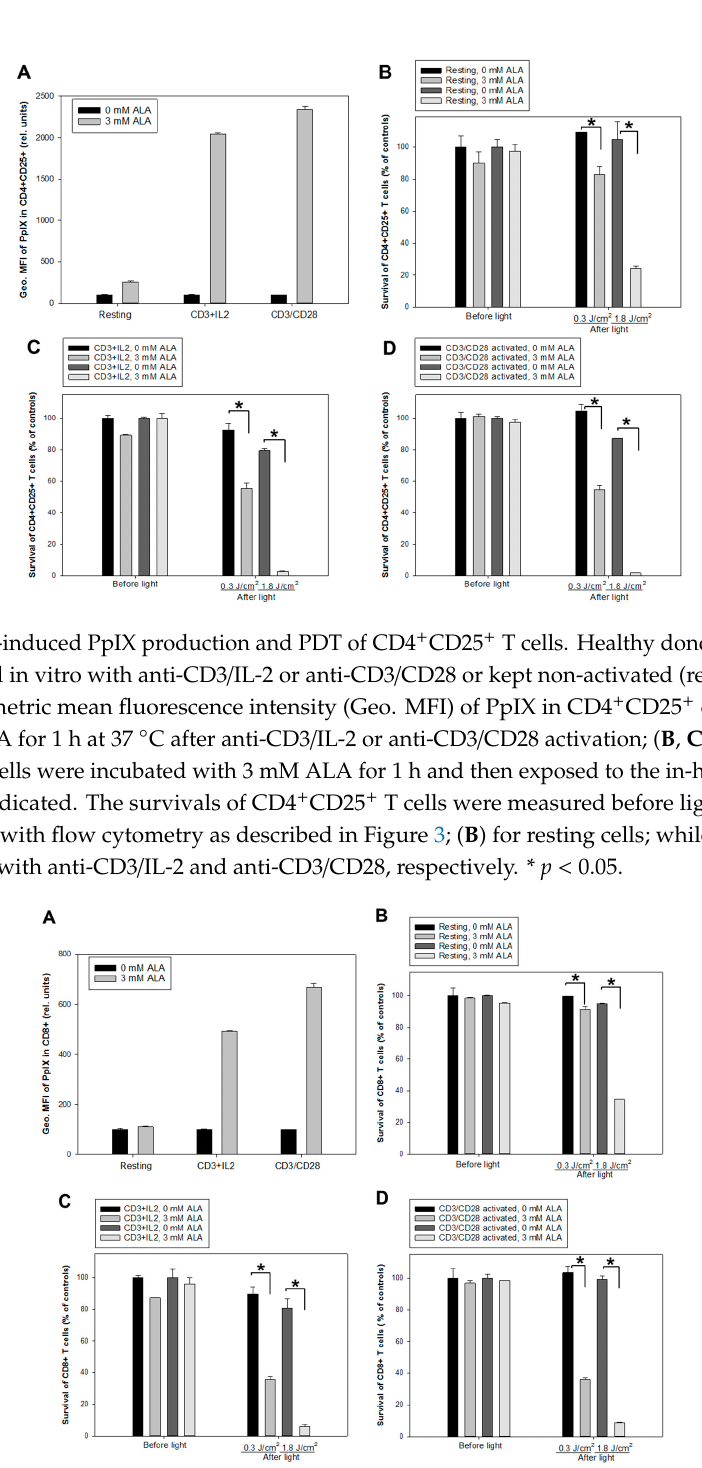
Figure 6. ALA-induced PpIX production and PDT of CD8 + T cells. Healthy donor PBMCs were either activated in vitro with anti-CD3/IL-2 or anti-CD3/CD28 or kept non-activated (resting) for 3 days. ( A ) geometric mean fluorescence intensity (Geo. MFI) of PpIX in CD8 + cells incubated with 3 mM ALA